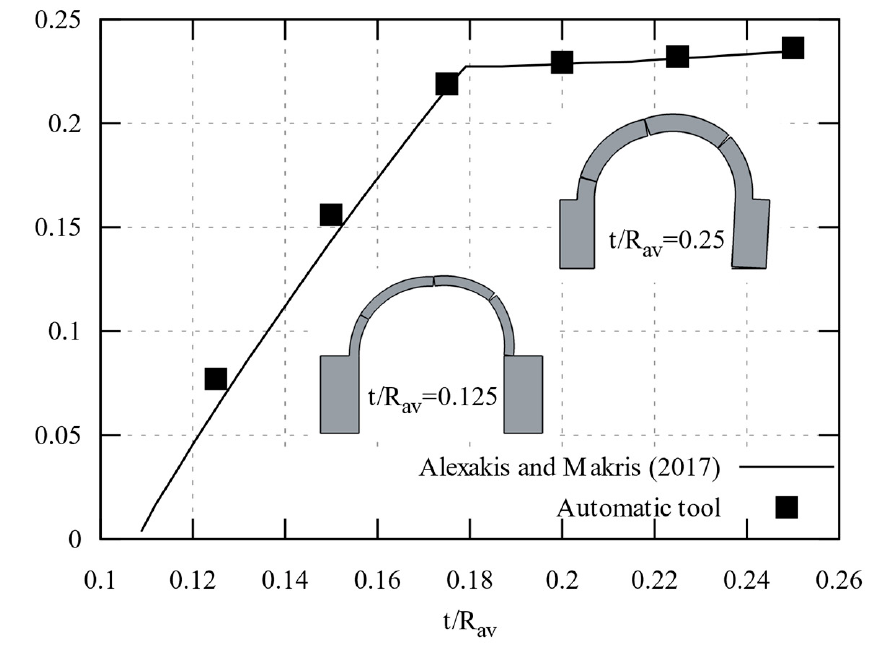
Figure 7. Validation of the automatic tool against the analytical results in [33]. The comparison with [33] shows a very good agreement, with only some minor differences observed for low values of t . This is due to the finite discretisation of the R av possible hinge location, as opposed to the continuous minimum search in the analytical formulation. The tool also correctly captures the change in collapse mode, from local to = 0.18, and the consequent stabilisation of the semi-global, approximately observed at t R av collapse multiplier. This will be confirmed in the analyses in Sections 3.2 and 3.3 A further investigation on the results of the automatic tool for limit analysis of but- tressed arches was performed considering the unreinforced system shown in Figure 8a. To investigate the influence of various material parameters on the collapse multiplier, the limit analysis results were compared with the results of a Discrete Macro-Element Model (DMEM), created by means of Histra Arches and Vaults software [21]. The DMEM approach entails the discretisation of the arch by means of plane irregular articulated quadrilateral elements, endowed with an internal shear deformability and nonlinear behaviour. The interaction between adjacent elements is modelled by means of nonlinear zero-thickness interfaces, with appropriate constitutive relationships which allow for the representation of typical arch failure modes, i.e., sliding and flexural failures (Figure